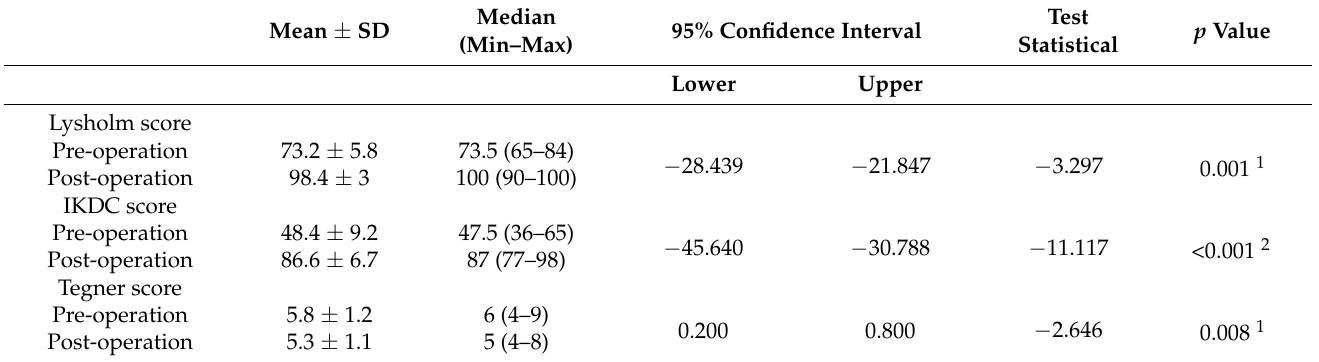
Table 2. Pre- and post-operative patient-reported outcome scores for Lysholm, IKDC and